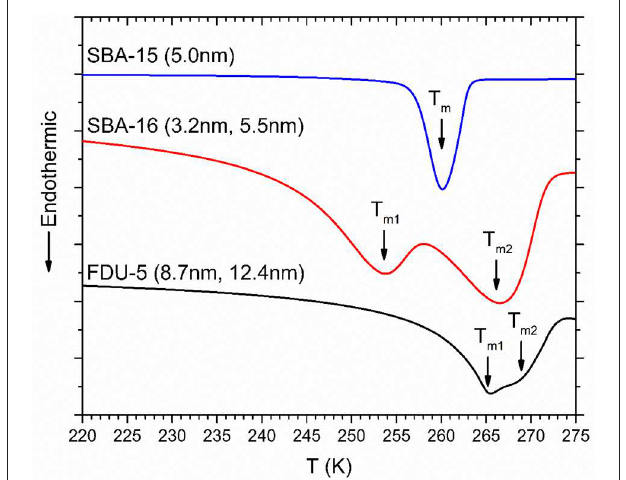
FIGURE 4 | DSC melting scans for D 2 O confined in SBA-15, SBA-16, and FDU-5. Corresponding pore diameters are given alongside the scans. 1 T m corresponding to melting in nanopores are indicated by solid arrows.